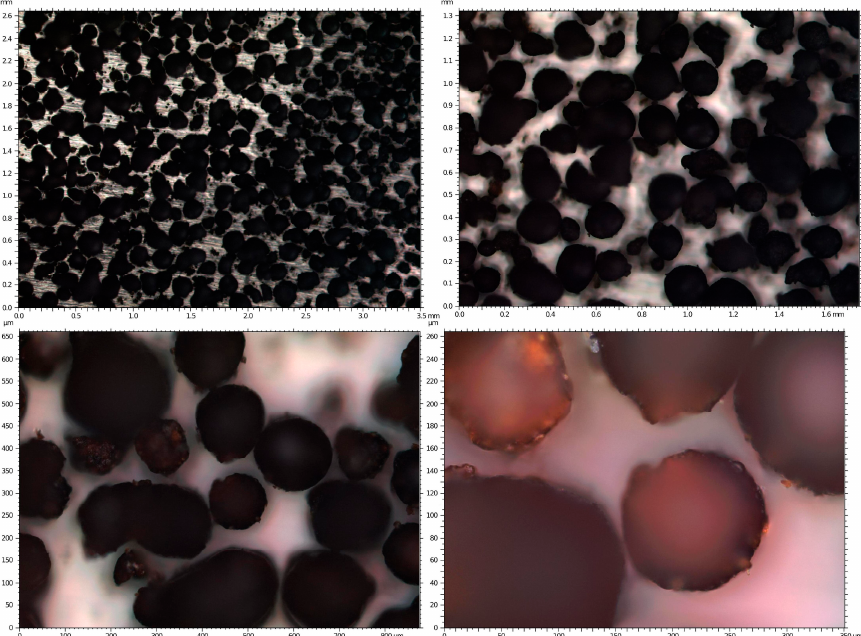
Figure 6. Lignin powder under the confocal microscope: × 5 ( top left ), × 10 ( top right ), × 20 ( bottom left ), × 50 ( bottom right